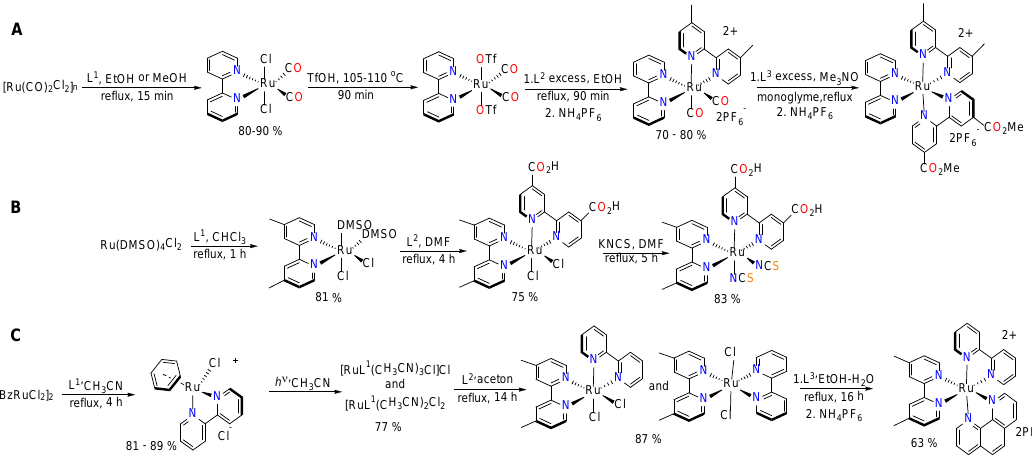
Scheme 1. Synthesis of tris -heteroleptic ruthenium complexes with polypyridine ligands. ( A – C ) represent routes starting from different sources of ruthenium. The scheme is build according to the published literature [35,38,39].